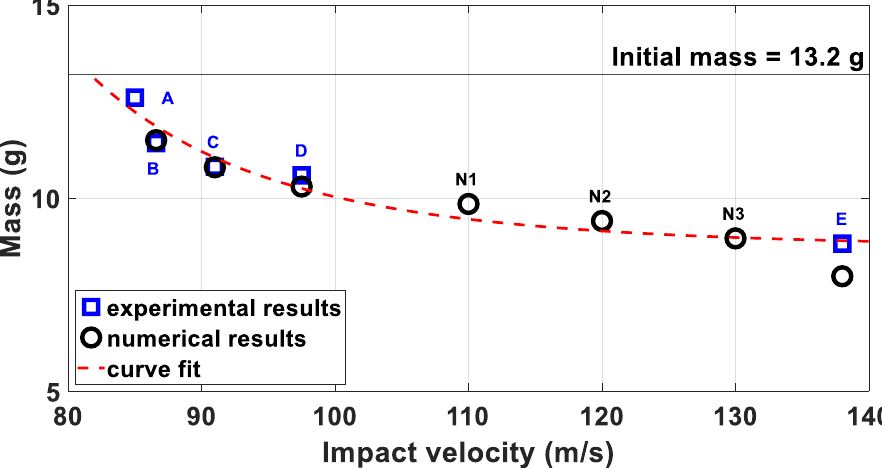
Fig. 7. Comparison between numerical and experimental results in terms of residual masses of samples at different impact velocities. The curve fit, displayed in red, was obtained from the experimental